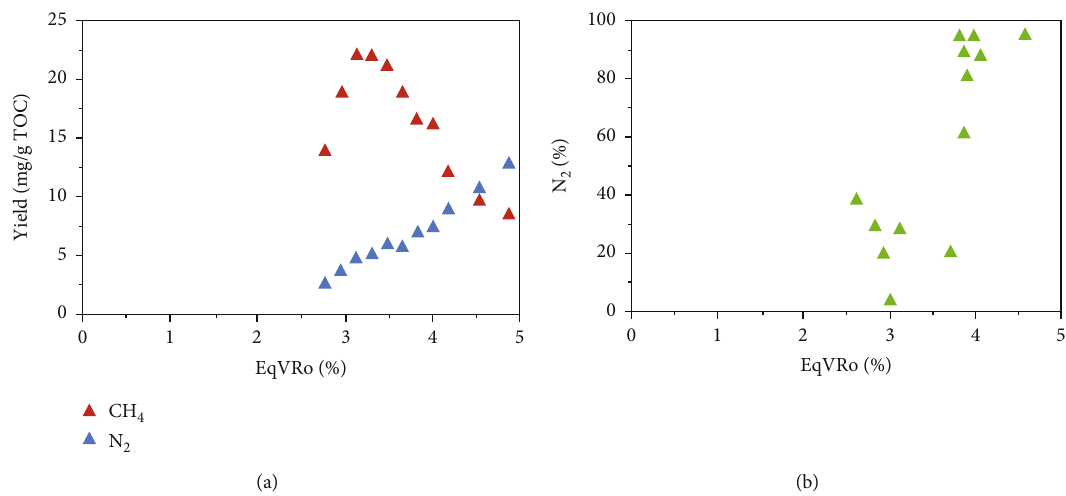
Figure 8: Cross-plots of the EqVRo value versus (a) CH [103]; Gai et